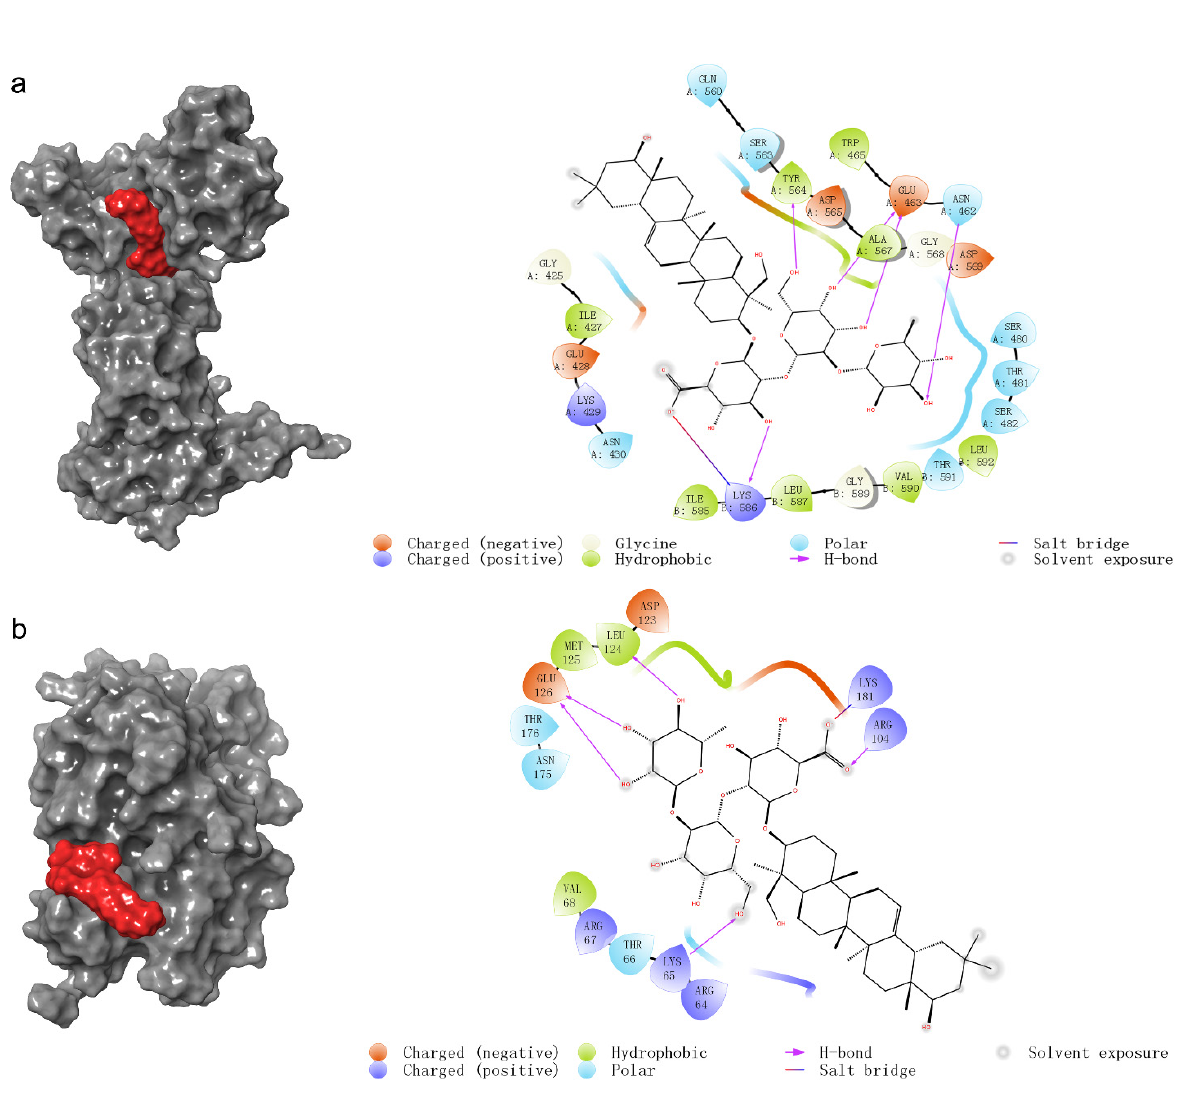
Figure 4. ( a , b ) Prediction of molecular docking between SsI and protein DNMT1 ( a ) and ERK1 ( b